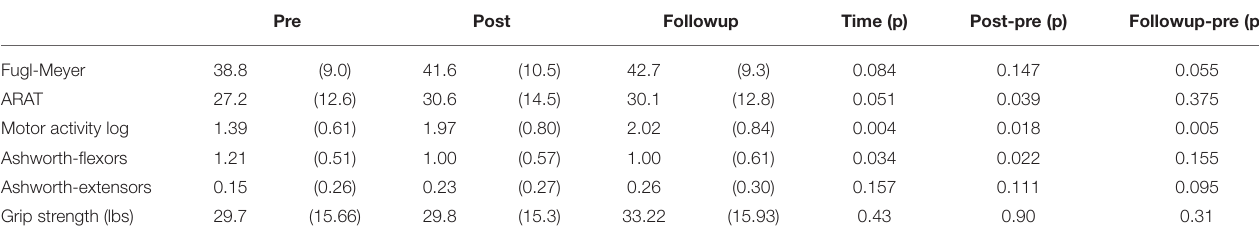
TABLE 4 | Mean change (SD) and statistical analysis of clinical outcomes. Pre Post Followup Time (p) Post-pre (p) Followup-pre (p)